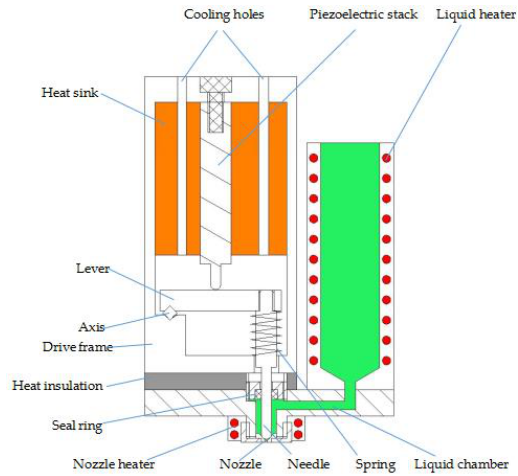
Figure 1. Structure of the jet printer.